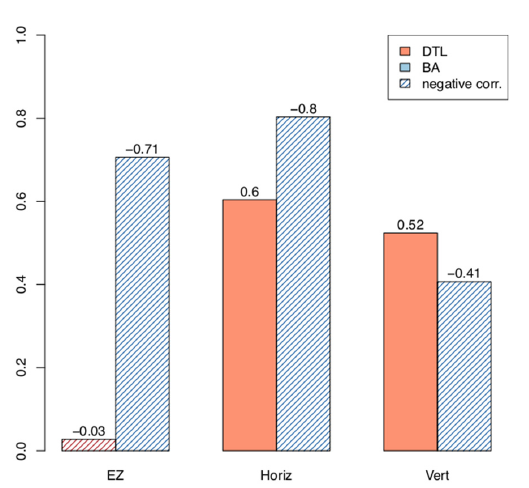
Figure 5. Correlations between progression rates of 30 Hz flicker electroretinogram (ERG) amplitude and structural parameters. Red bars represent correlations in the DTL group, while blue bars represent those in the BA group. Bars with shaded lines denote the negative correlations. ‘EZ’, ‘Horiz’, and ‘Vert’ denote the ellipsoid zone line width, the horizontal ring diameter, and the vertical ring diameter, respectively.